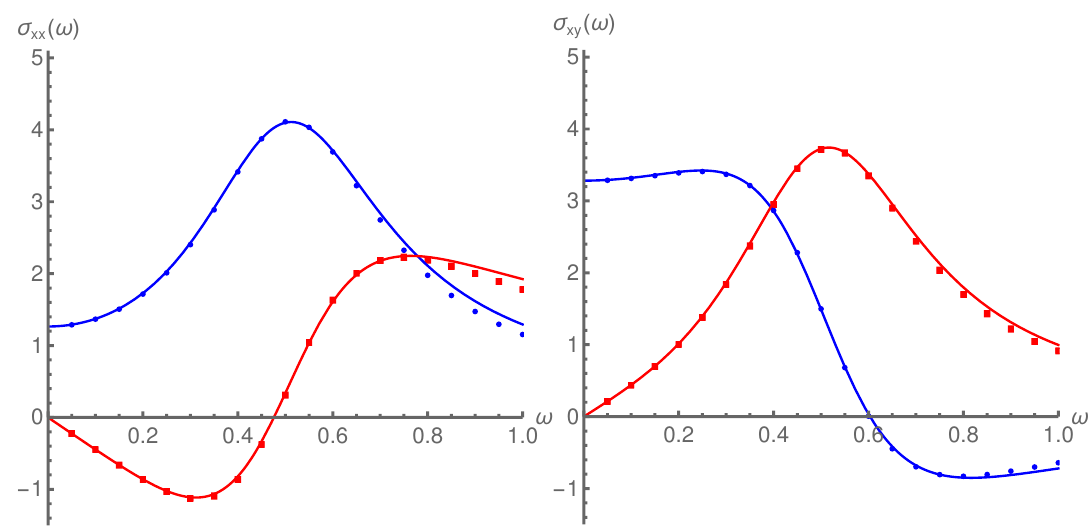
Figure 4 . The (left) longitudinal and (right) Hall optical conductivities of the homogeneous phase ( µ = 4 ) with b = 2 , with the real part shown in blue and the imaginary part in red. Dots are the numerically computed points, and the curves show the fits to (3.16) and (3.18). σ by requiring that the DC conductivity σ (0) is given by the results obtained from (A.35) xx Q after inserting the background geometry and the sliding speed ˆ v x